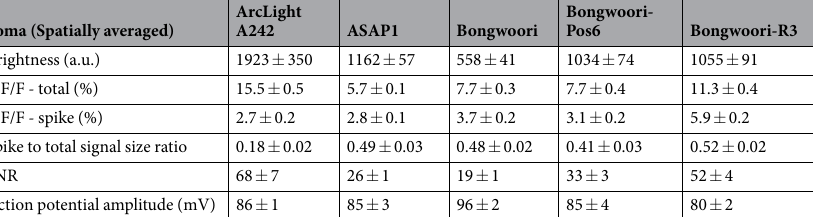
Table 3. Characteristics of GEVIs resolving evoked action potentials from cultured mouse hippocampal neurons. All analyzed data were acquired by spatially averaging pixels corresponding to the soma. Values were shown as mean ± SEM (standard error of the mean). The number of action potentials analyzed; ArcLight: 12, ASAP1: 12, Bongwoori: 11, Bongwoori-Pos6: 11, Bongwoori-R3: 12, all from three cells for each GEVI.